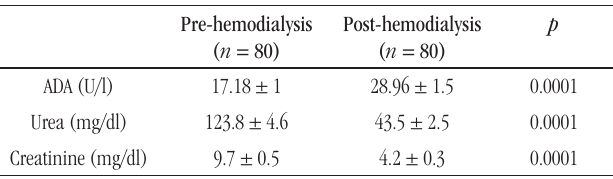
taBLE 1 − Comparison of laboratory analyses between pre- and post-hemodialysis periods Pre-hemodialysis ( n = 80)